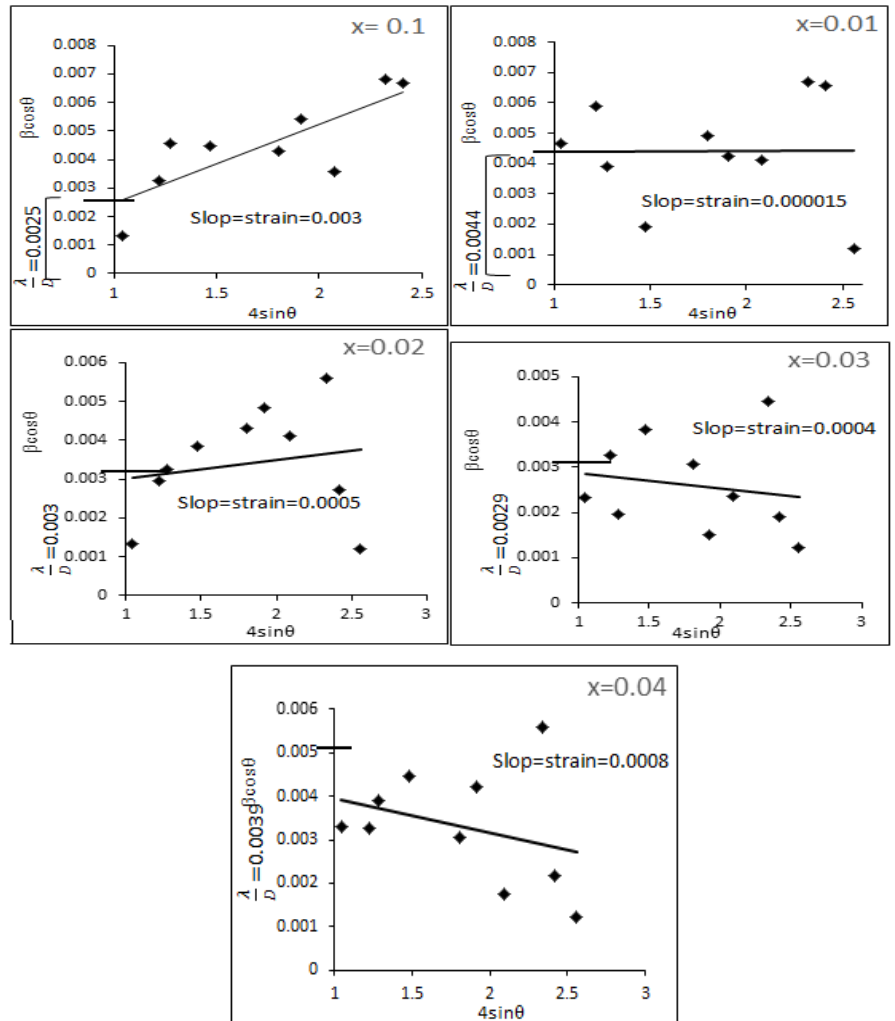
Fig. 2: Williamson and Hall plot graphs for Ni 0.03,